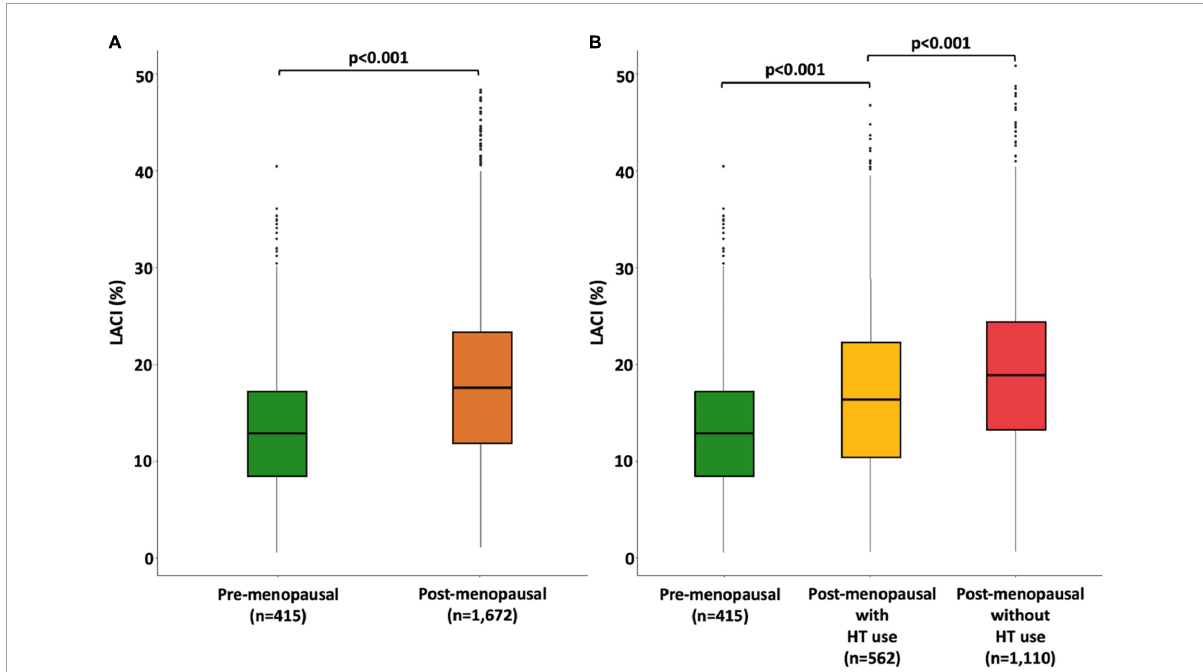
FIGURE2 Boxplot distribution of the LACI measured at baseline stratified by menopause status (A) and by both menopausal status and hormone therapy use (B) . The bottom and top of the box are the first and third quartiles, and the band inside the box is the second quartile (the